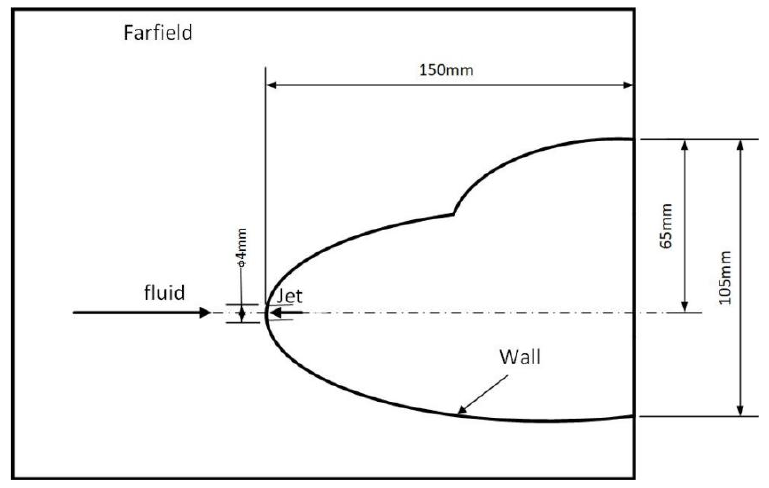
Figure 7. Schematic view of the double ellipsoid structure.